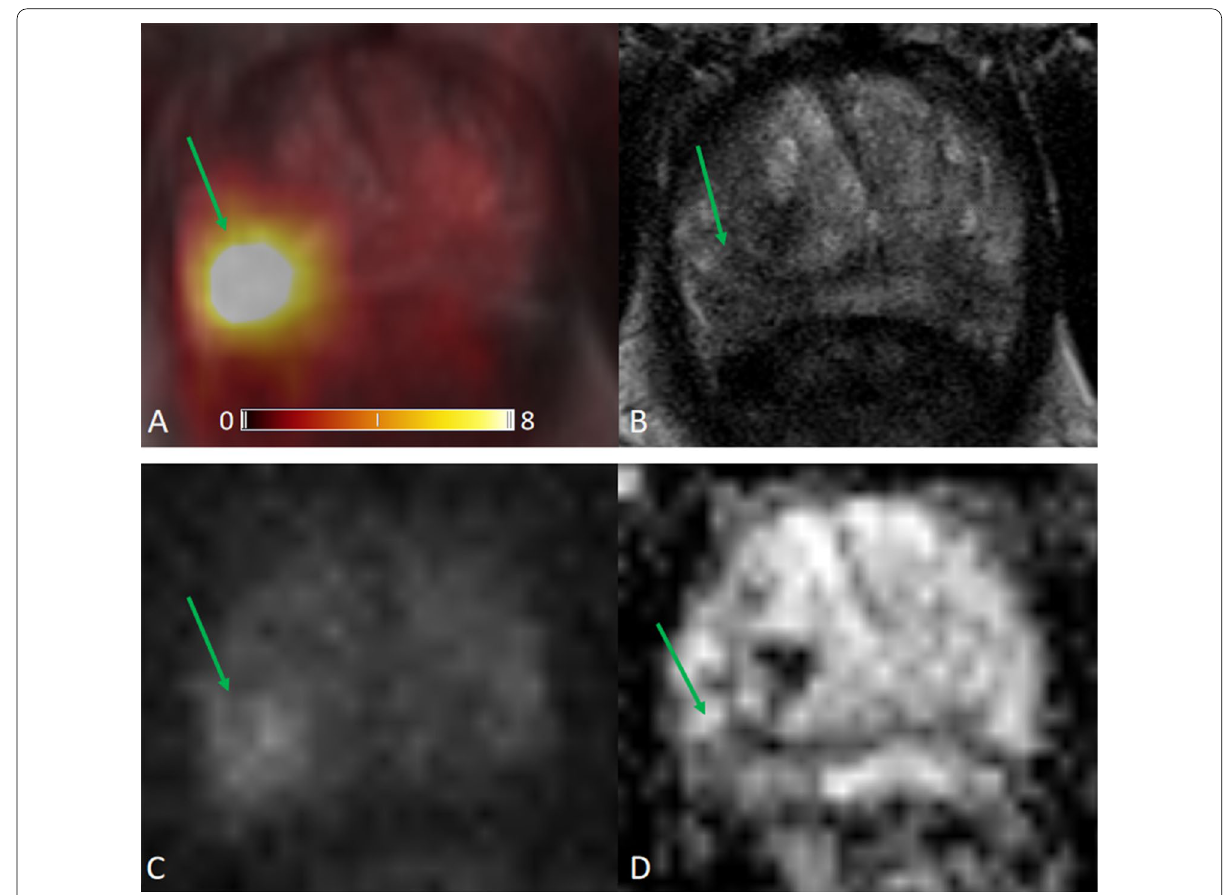
Fig. 6 [ 68 Ga]Ga-PSMA PET/MRI images obtained in a 76-year-old man, PSA 9.50 ng/mL. a [ 68 Ga]Ga-PSMA PET/MRI; b T2WI; c DWI, b value 1000 s/ mm 2 ; d ADC. This example showed MRI-positive lesions, PI-RADS 4, with apparent PSMA uptake in [ 68 Ga]Ga-PSMA-11 PET.a MRI-negative lesions, a typical encapsulated nodule with unapparent radiotracer uptake in [ 68 Ga]Ga-PSMA-11 PET. SUVmax 13.6, right PZ, background SUVmax 1.5, LBR 9.1